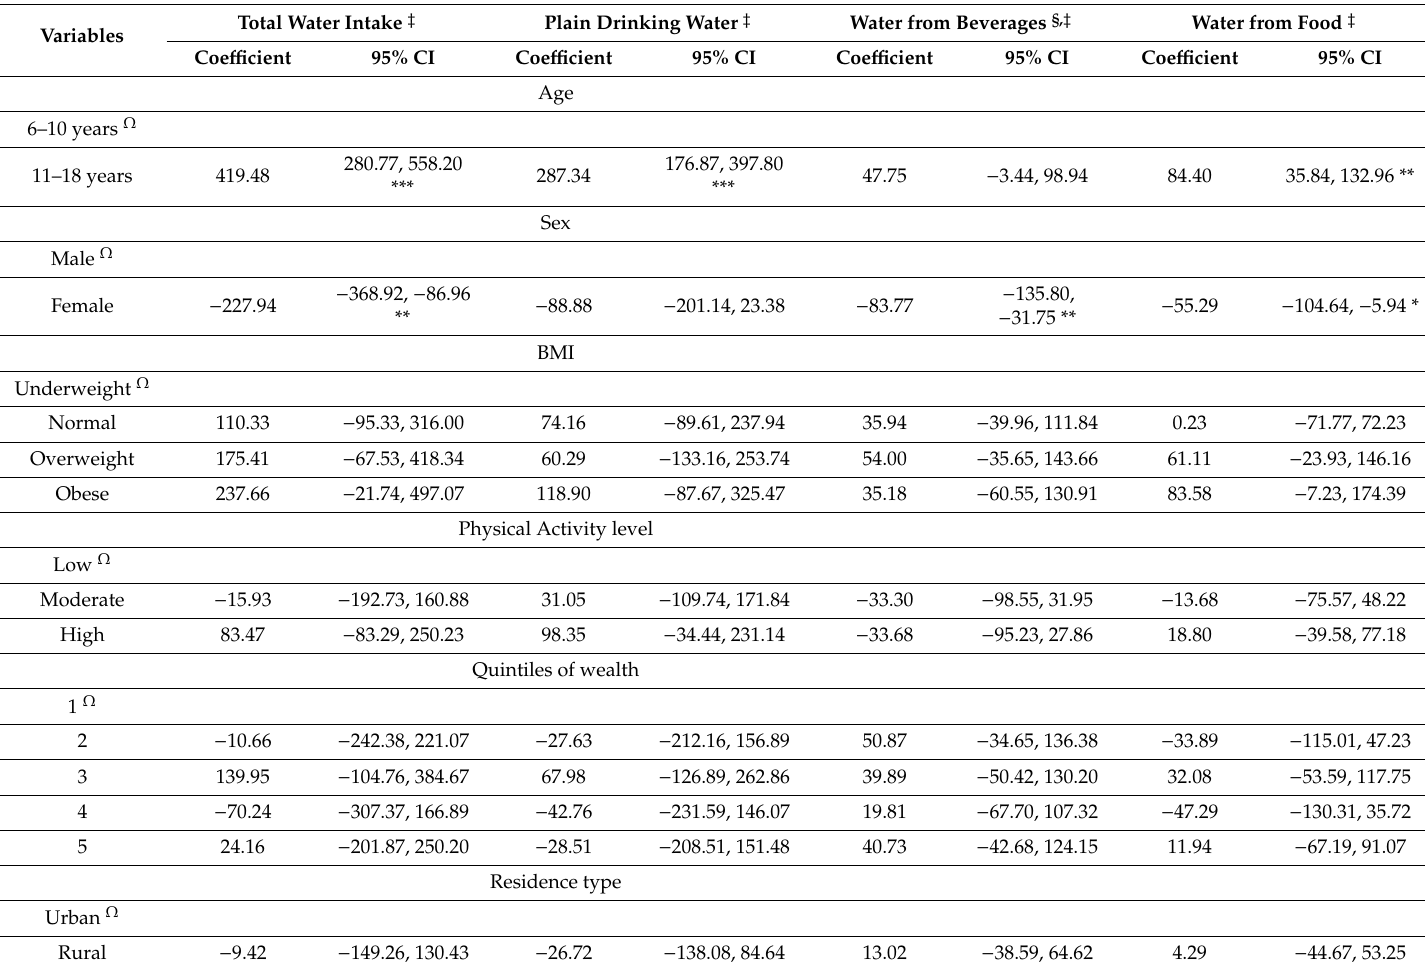
Table 2. Multiple linear regression of water intake from drinking and the consumption of food and beverages, by sociodemographic characteristics (n = 464).